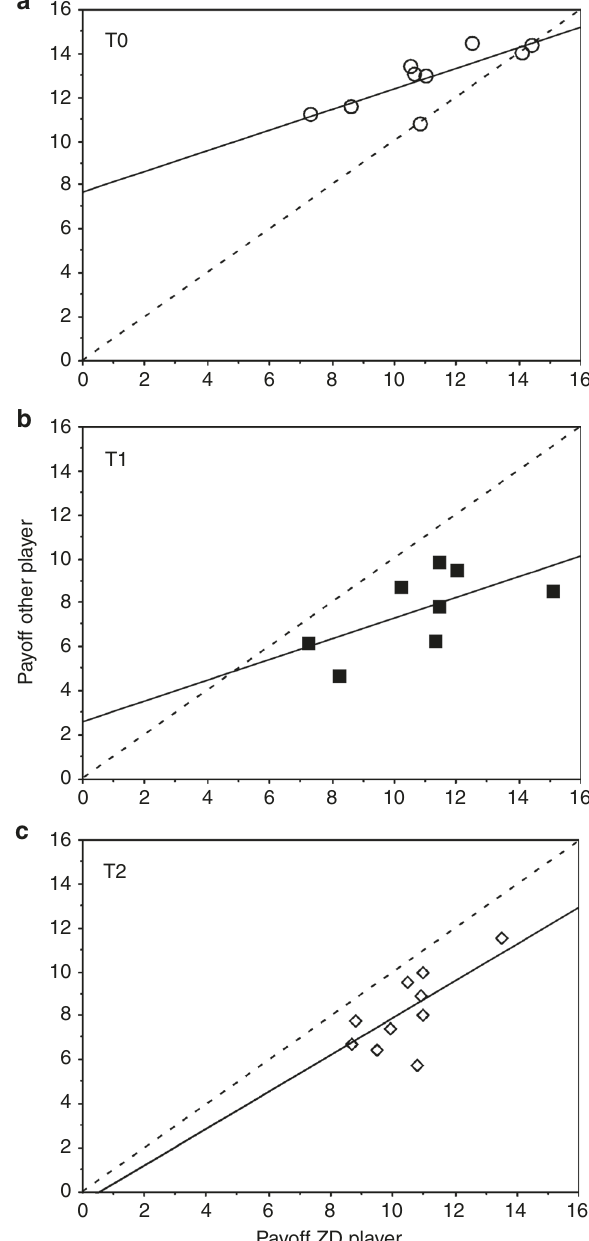
Fig. 2 Payoffs of each player dependent on cooperation of inferior player.